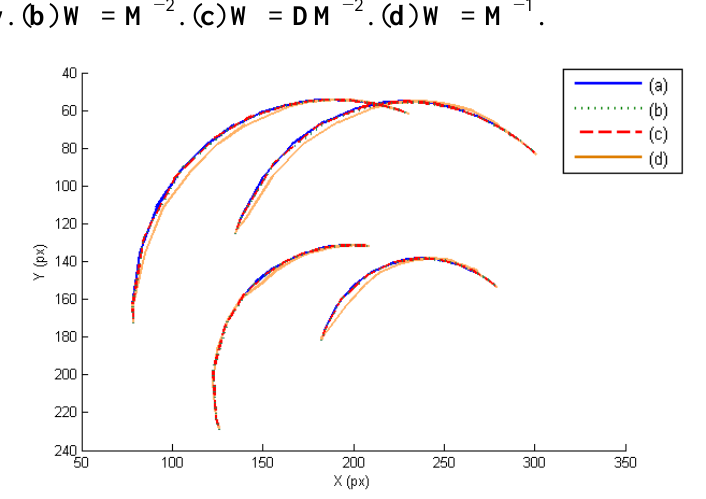
Figure 7. Image trajectories obtained during the second set of experiments. ( a ) Desired image trajectory. ( b ) W = M −2 . ( c ) W = DM −2 . ( d ) W = M −1 .